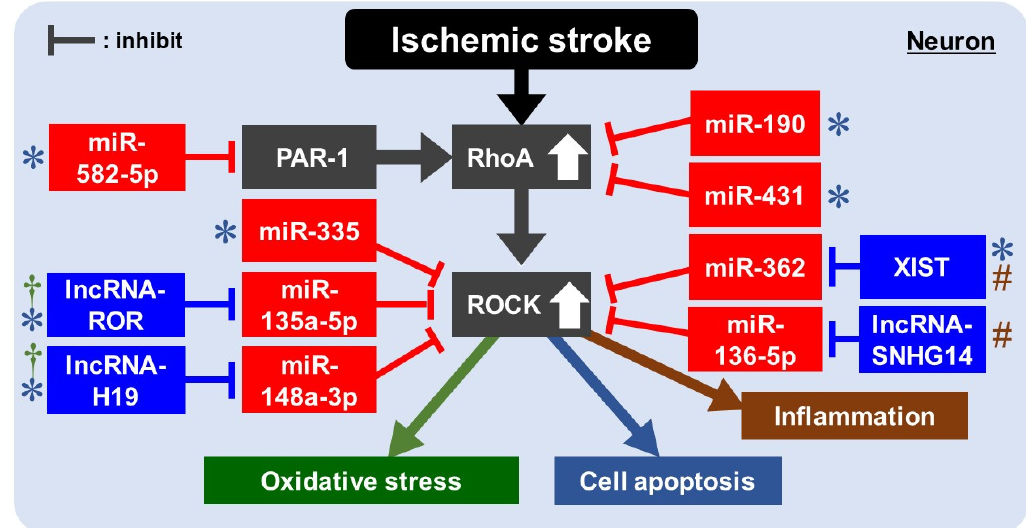
Figure 2. Schematic representation of the interaction between the Rho/ROCK pathway and ncRNAs in ischemic strokes. Ischemic strokes trigger multiple detrimental pathways, including the RhoA/ROCK pathway, leading to oxidative stress, cell apoptosis, inflammation, and excitotoxicity. MiRNAs inhibit oxidative stress, cell apoptosis, and inflammation via the inhibition of RhoA or ROCK upregulation in neurons. LncRNAs exacerbate ischemic injuries via the downregulation of miRNAs. † miRNA/lncRNA involving oxidative stress. * miRNA/lncRNA involving cell apoptosis. # miRNA/lncRNA involving inflammation. PAR-1: proteinase-activated receptor type I; ROR: regulator of reprogramming; XIST: X-inactive specific transcript; SNHG14: small nucleolar RNA host gene 14; ROCK: Rho-kinase.